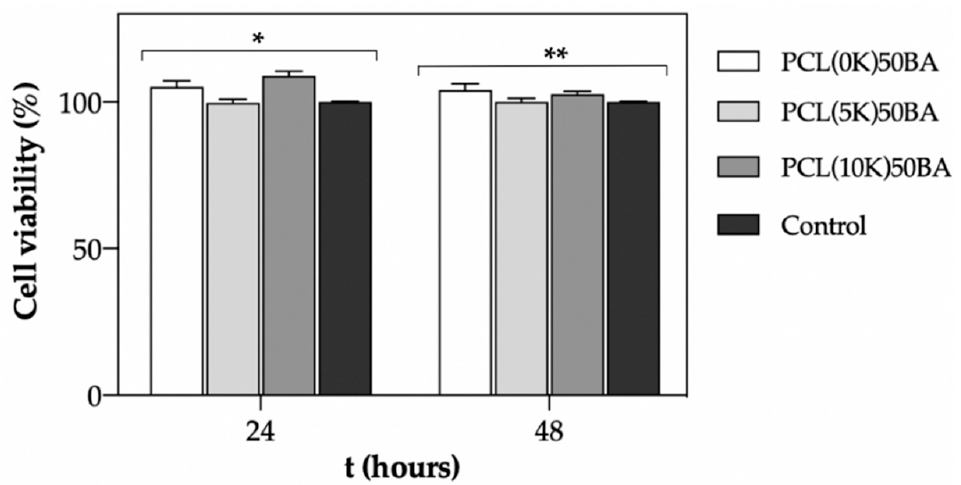
Figure 9. Fibroblast cell viability determined by CCK-8 test after 24 and 48 h of direct contact with the manufactured scaffolds. Viability was expressed in percentage. Equal symbol denotes statistically homogeneous groups (1 way-ANOVA; p < 0.05).